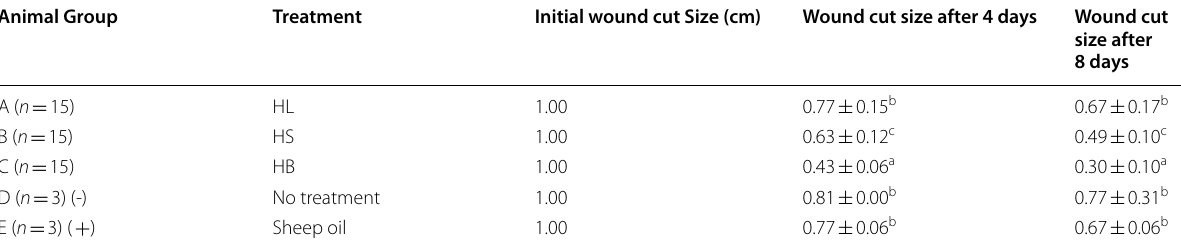
Values followed with the same letters (a, b and c) in column are not significantly different ( p > 0.05), values with different letters are significantly different ( p < 0.05) (Tukey’s HSD test at p =